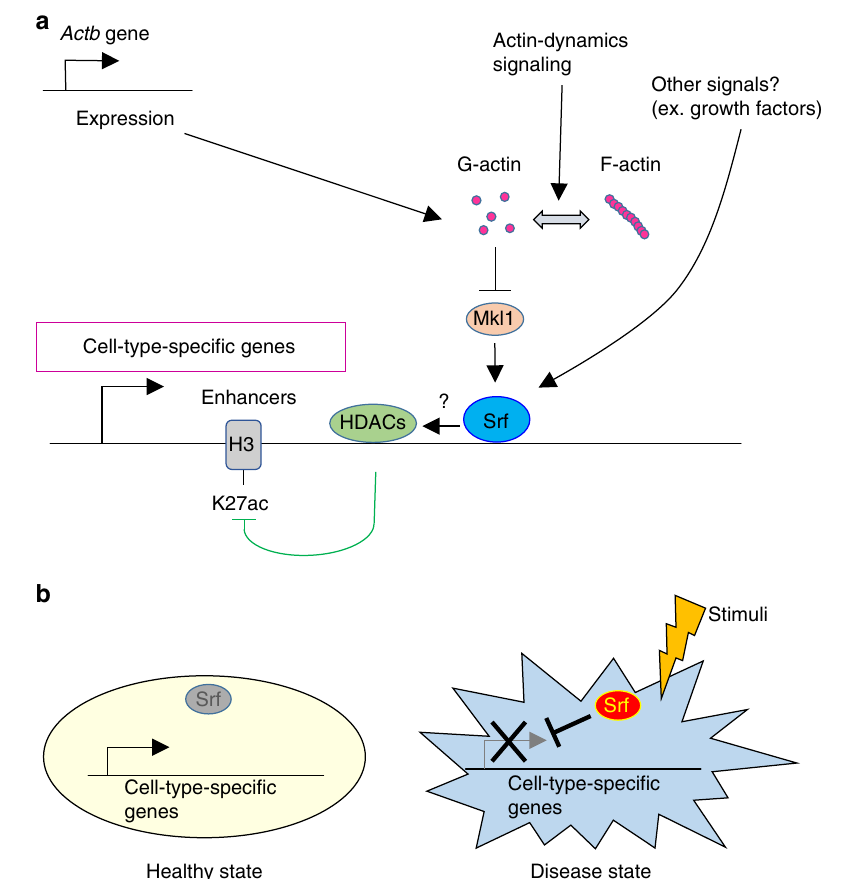
Fig. 7 A schematic model indicating that Srf destabilizes cell identity by repressing cell-type-speci fi c genes. a A model of Srf-related pathways to repress cell-type-speci fi c gene expressions. Srf preferentially binds to open regions which preferentially contain cell-type-speci fi c genes. Various signals, such as Actb expression changes and β -actin polymerization dynamics, are transduced to Srf. Srf activated by Mkl1 inactivates the surrounding regions, possibly by recruiting or activating HDACs. Other signals that regulate Srf through β -actin-independent pathways could also participate in this regulation. b A schematic view of a possible mechanism by which misactivation of Srf causes diseases. When the activity of Srf is at physiological levels, cell-type-speci fi c genes are normally expressed. On the other hand, when Srf is activated at non-physiological levels (misactivation), these genes are repressed, triggering malfunction of the cells and tissues and sometimes leading to